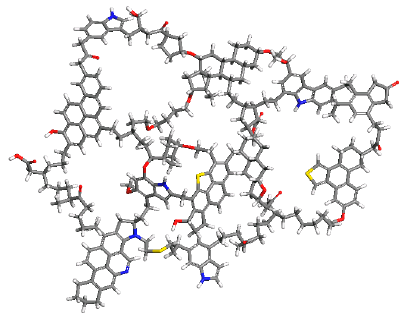
Figure 1. The molecular structure of kerogen.